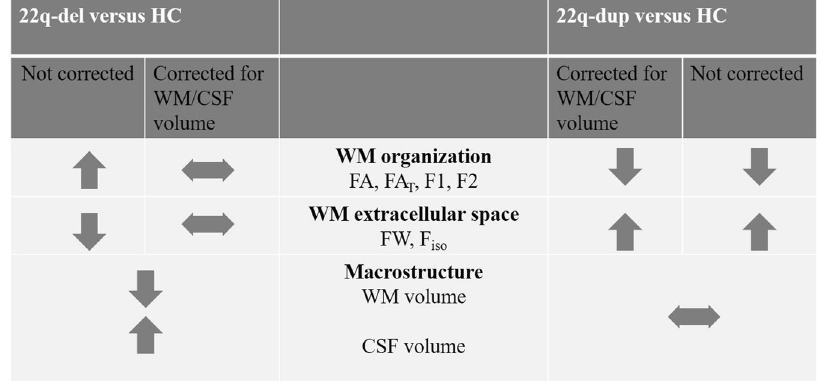
Fig. 4 Summary of overall results. When not correcting for macroscopic volumes, 22q11.2 deletion (22q-del) and 22q11.2 duplication carriers (22q-dup) show opposite patterns of white matter (WM) changes compared with healthy controls (HC). Signi fi cant macrostructural changes (lower WM/ higher cerebrospinal (CSF) volume) were found in 22q-del but not in 22q-dup. When controlling for macrostructural effects, microstructural changes are no longer signi fi cant in 22q-del but remain signi fi cant in 22q-dup. Taken together, these results do not support gene dosage as a direct cause for micro- or macrostructural differences in 22q-del and